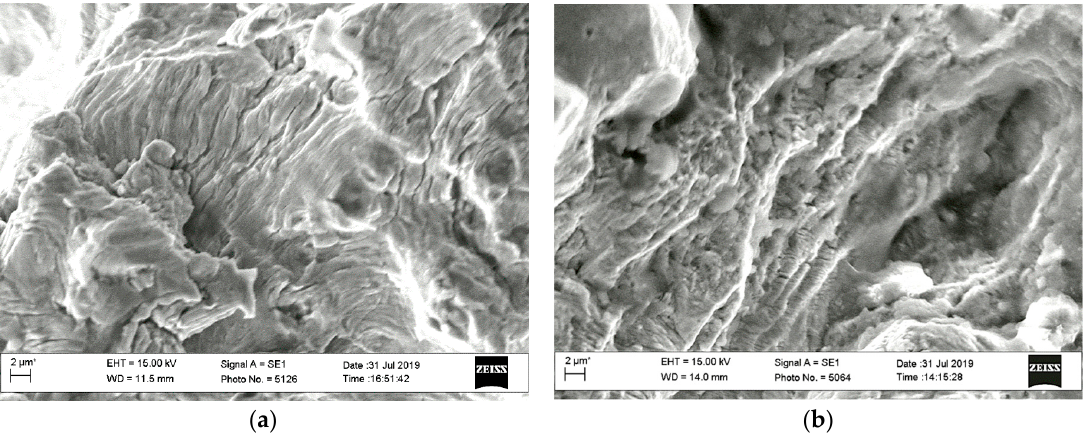
Figure 16. Fractograms of specimens obtained at a distance between 1 and 3 mm from their side-surfaces at the final stage of the starting fracture zones of specimens loaded at K I – K III type: ( a ) Up to 30 degrees by K III ; ( b ) up to 45 degrees by K III .